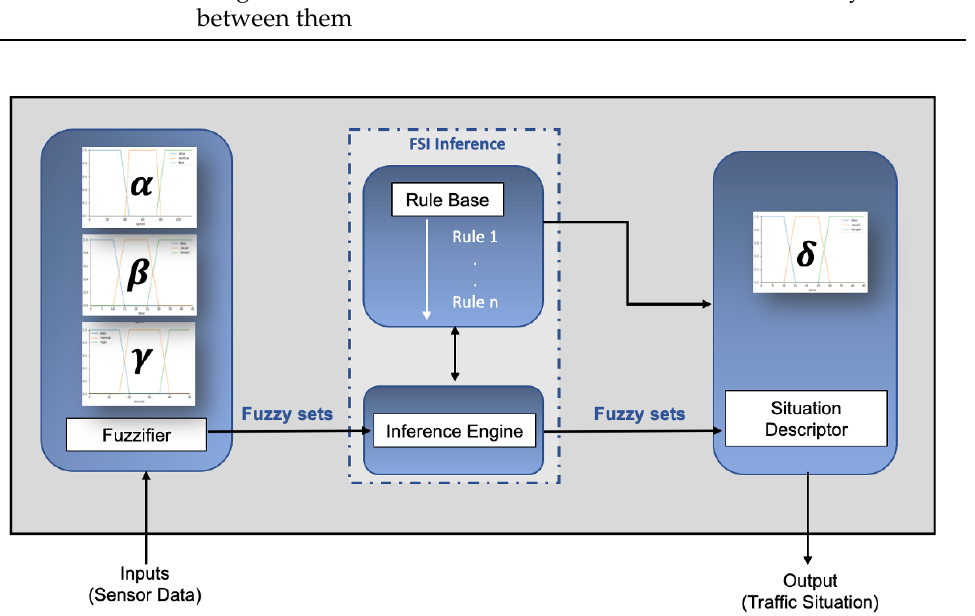
Figure 5. FSI based Situation Description